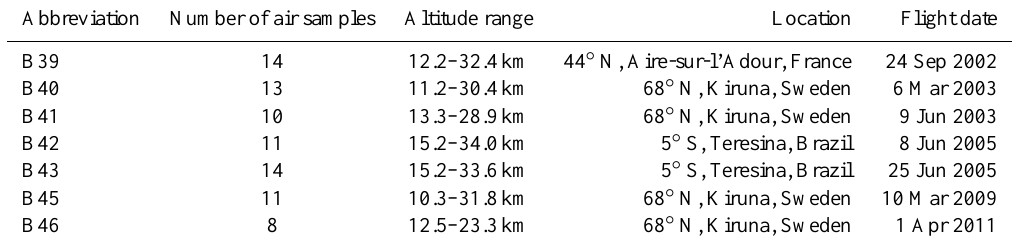
Table 1. Abbreviation, number of air samples, altitude range, location, and flight date of the cryosampler flights considered for the validation. The abbreviation BXX refers to flight no. XX of the balloon-borne whole air samplers. University of Frankfurt operates two nearly identical cryogenic whole air samplers allowing the performance of two flights during a